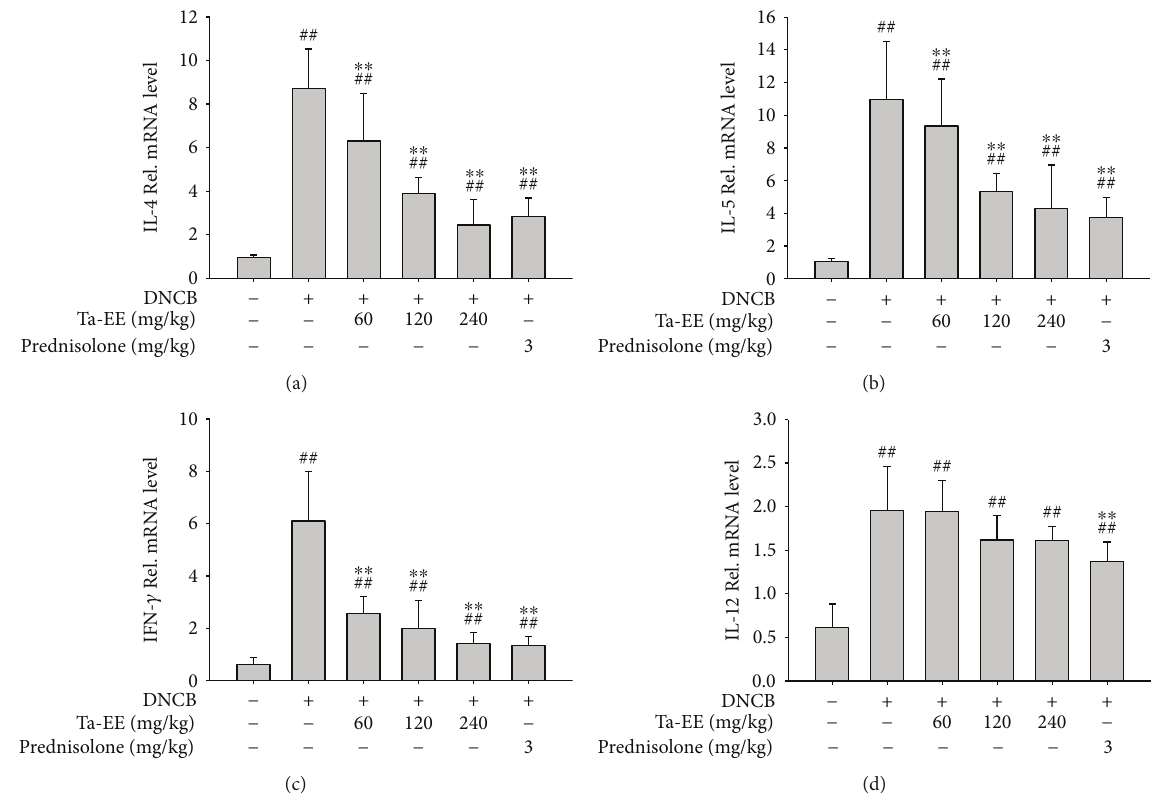
Figure 3: E ff ects of Ta-EE on mRNA expression of proin fl ammatory cytokines in the atopic dermatitis skin lesions of DNCB-induced AD mice. DNCB-induced AD mice were orally administered with either Ta-EE (0, 60, 120, and 240 mg/kg) or prednisolone (3 mg/kg) once a day for 4 weeks. The atopic dermatitis skins were excised from the AD mice after sacri fi ce at week 4. The mRNA expression levels of (a) IL-4, (b) IL-5, (c) IFN- γ , and (d) IL-12 in the atopic dermatitis skins were determined using quantitative real-time PCR. ∗∗ P < 0 005 versus a control group; ## P < 0 005 versus a normal